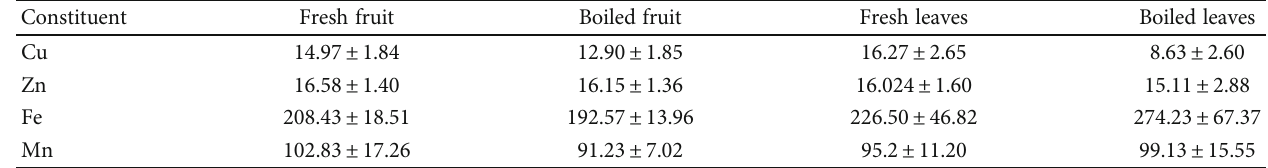
Table 1: Mean ± SE Concentration (mg/Kg) of micronutrient in Solanum torvum (n =6). Constituent Fresh fruit Boiled fruit Fresh leaves Boiled leaves